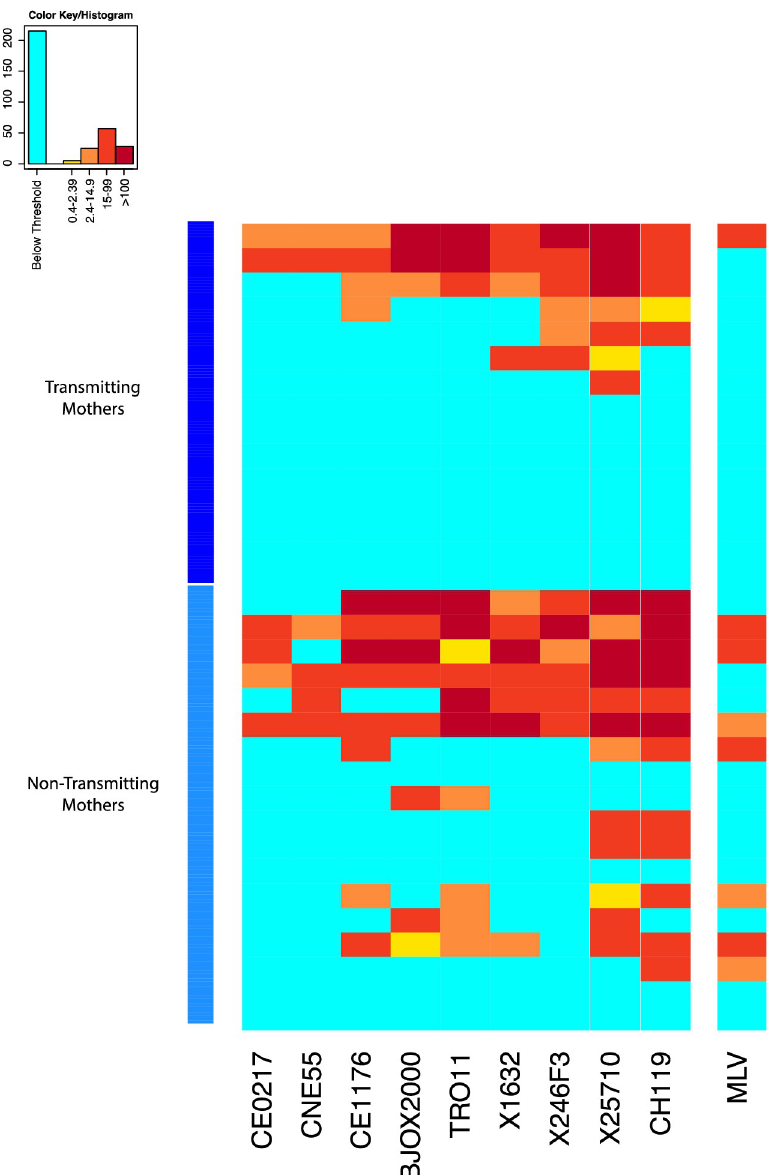
Fig 6. Neutralization sensitivity of global panel of heterologous tier 2 viruses to plasma from transmitting and non-transmitting mothers. Rows represent viruses and columns represent plasma from the transmitting and non- transmitting mothers. The darker hues indicate more potent neutralization, and aquamarine indicates ID 50 s below threshold, unable to reach this level of neutralization at the lowest dilution. Top rows (indicated by the dark blue column to the left) are the plasma from the transmitting mothers, below (light blue on the left) are plasmas from transmitting